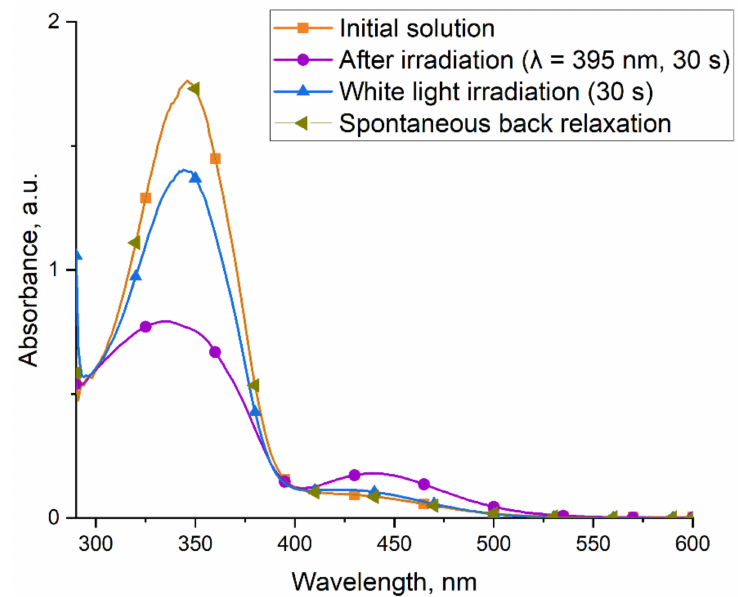
Figure 5. UV/Vis absorption spectra of ethercaine ( 6 ) before and after irradiation of its solution. A short-term study of the stability of a solution of the Z -form of ethercaine in the dark at room temperature for 5 min did not show any significant changes in the absorption spectrum, which indicates that the Z -form of the compound is sufficiently stable. The half-life of the Z -form of ethercaine in micellar solution was ca. 65 min (determined by the ( λ = 420–700 nm) for 30 s led to the recovery of the compound to the photostationary